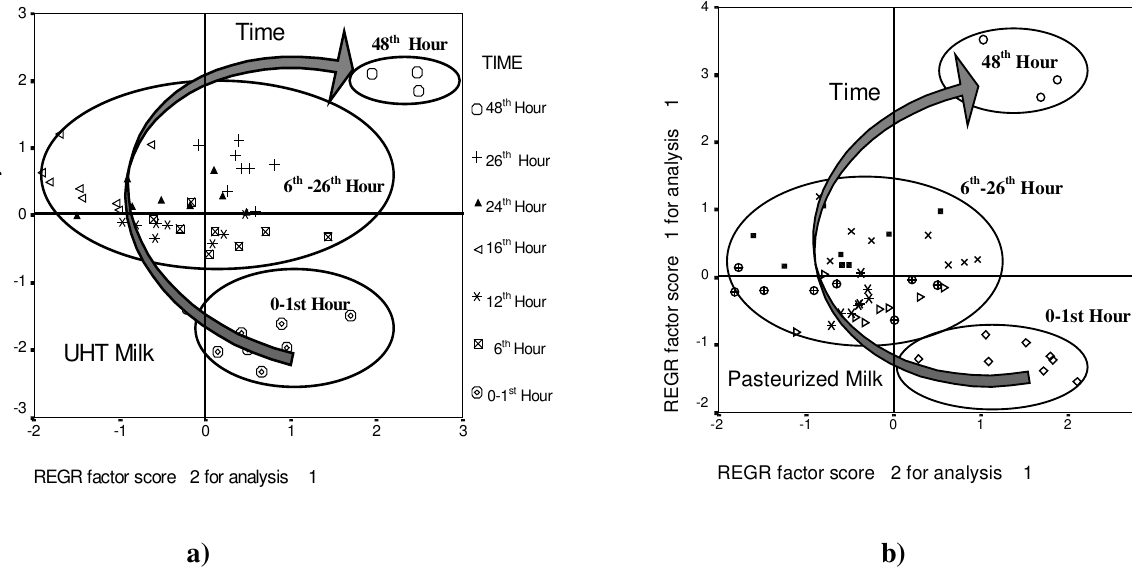
Figure 6.‘Score plots’ of a principal component analysis. First and second principal component correlated with the storage time.(a) UHT Milk and (b) Pasteurized